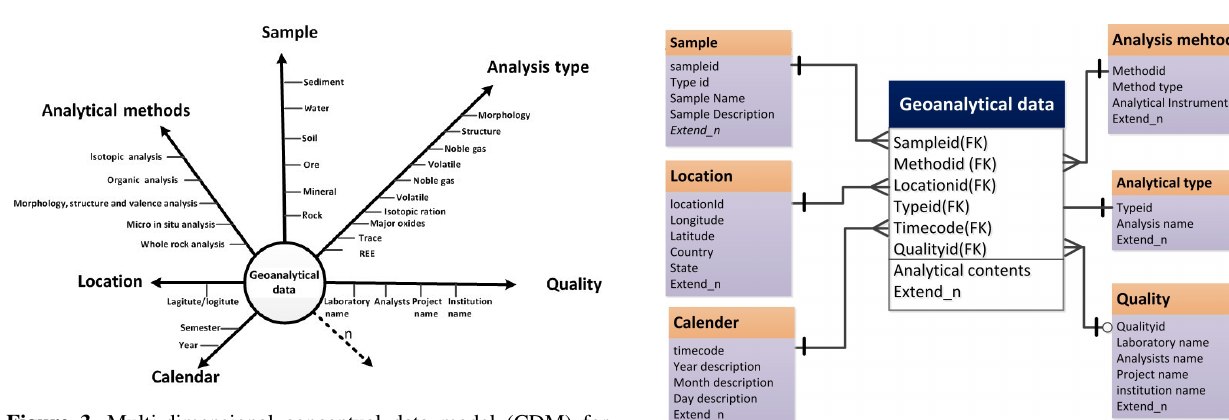
Figure 3. Multi-dimensional conceptual data model (CDM) for geoanalytical data.